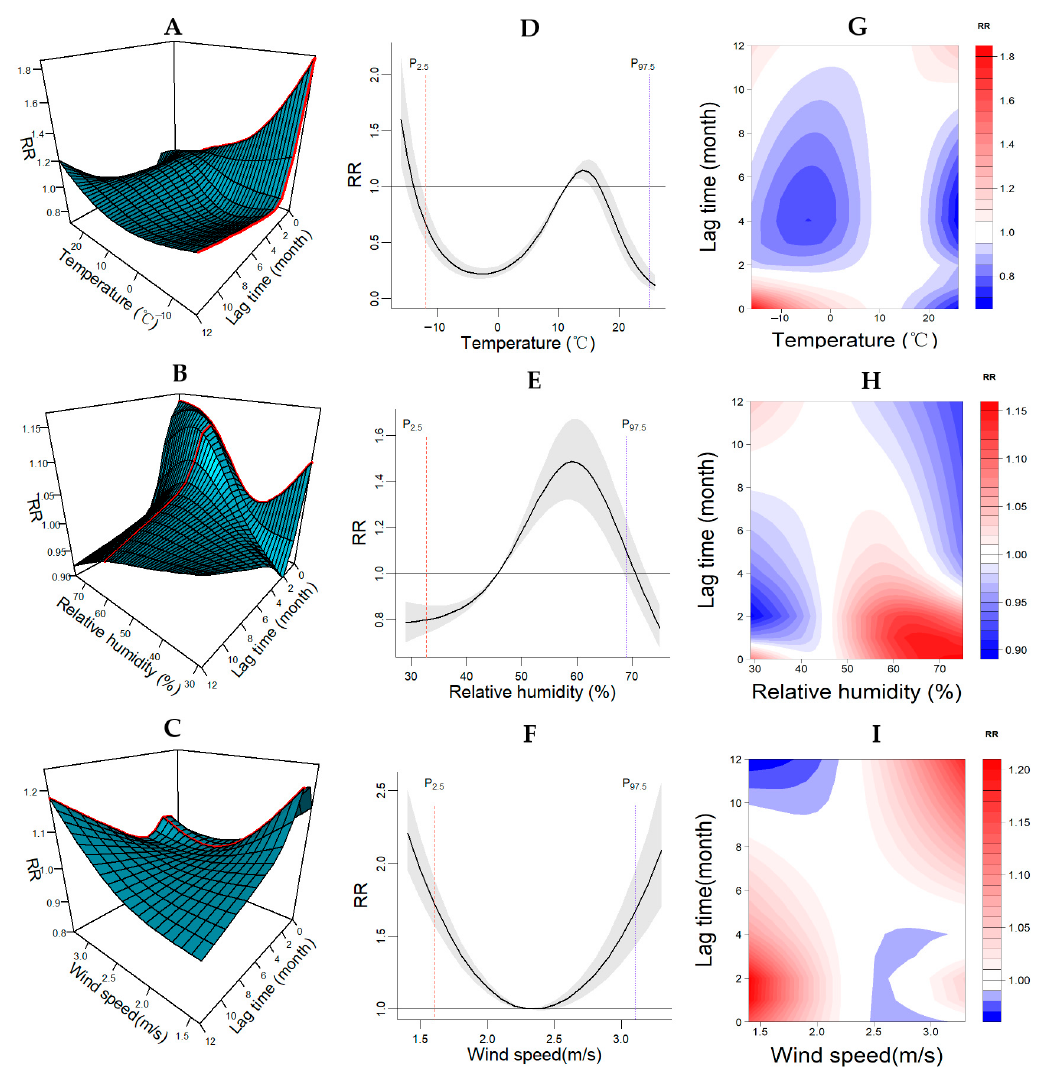
Figure 3. The exposure-lag-response correlations between meteorological factors and PTB incidence in Xinjiang from 2004 to 2019. ( A – C ) represent the 3–D graphs of the relationships between air temperature, relative humidity, wind speed and PTB incidence, respectively. ( D – F ) represent the overall cumulative relative risks of air temperature, relative humidity, wind speed on PTB incidence acrosslag 0–12 months, respectively. ( G – I ) represent the heatmaps of air temperature, relative humidity, wind speed on PTB incidence,